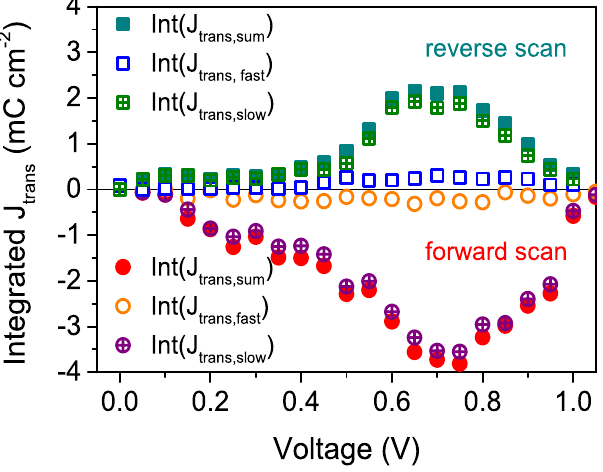
Figure 4. Fast and slow time constants ( τ fast and τ slow ) extracted by fitting the transient current response in each voltage segment to the bi-exponential fit function given in Equation (1) both for the forward scan and for the reverse scan